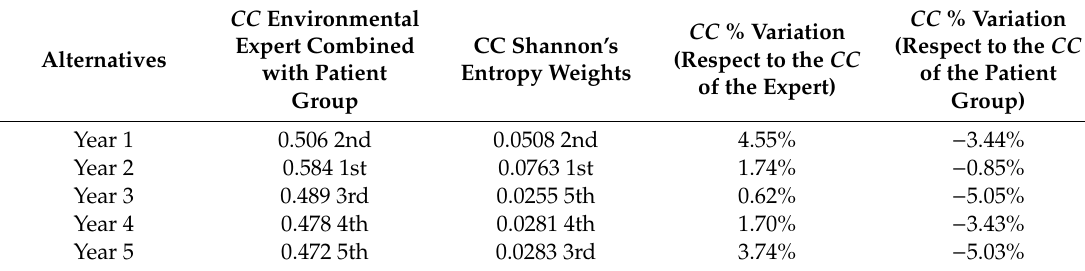
Table 10. Closeness coe ffi cient of environmental expert integrated with patient group in each year